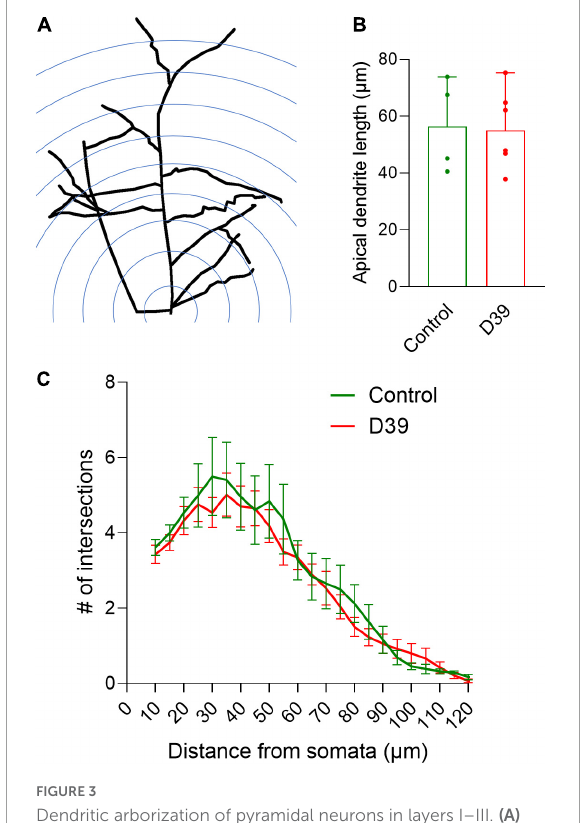
FIGURE3 Dendritic arborization of pyramidal neurons in layers I–III. (A) Diagram of the Sholl analysis method for dendritic intersection quantification (for details see section “2. Materials and methods”). (B) Average length of the apical dendrite (in both groups, there were equivalent portions of pyramidal neurons with much shorter apical dendrites, presumably staining artifact). Values represent median ± 95% CI. (C) Distribution of the dendritic intersections between both groups demonstrates identical shapes. Measurement radius was limited to 130 µ m to minimize the effect of staining artifacts along longer neurites. Values represent mean ±